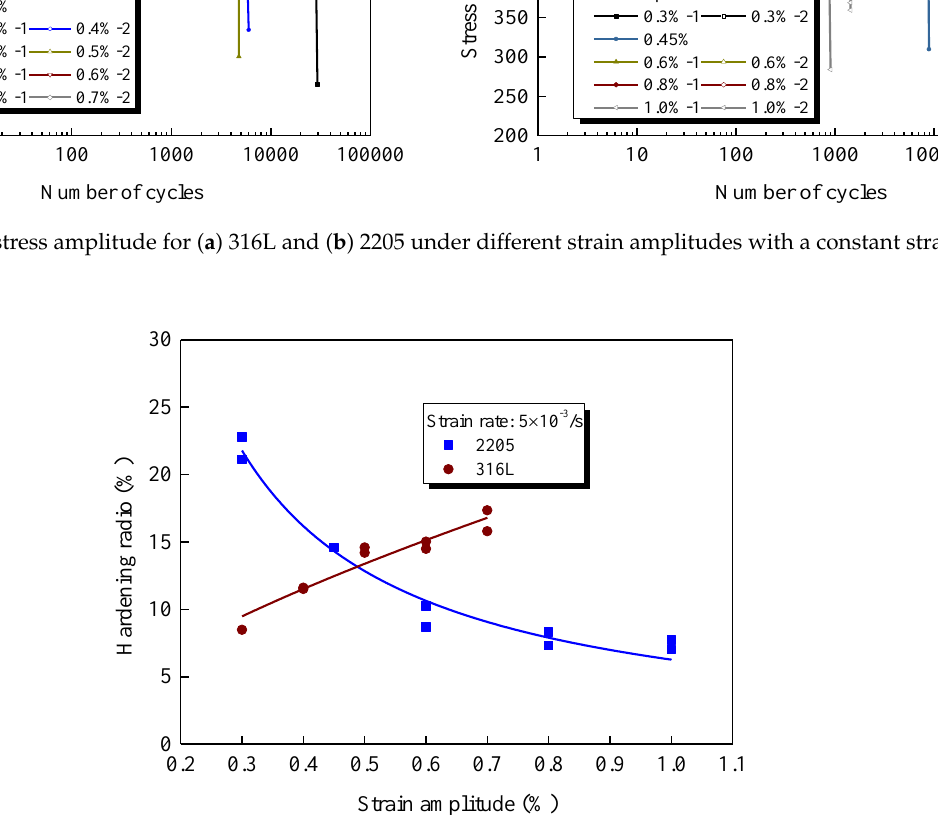
Figure 5. Hardening ratios under different strain amplitudes for 2205 and 316L.